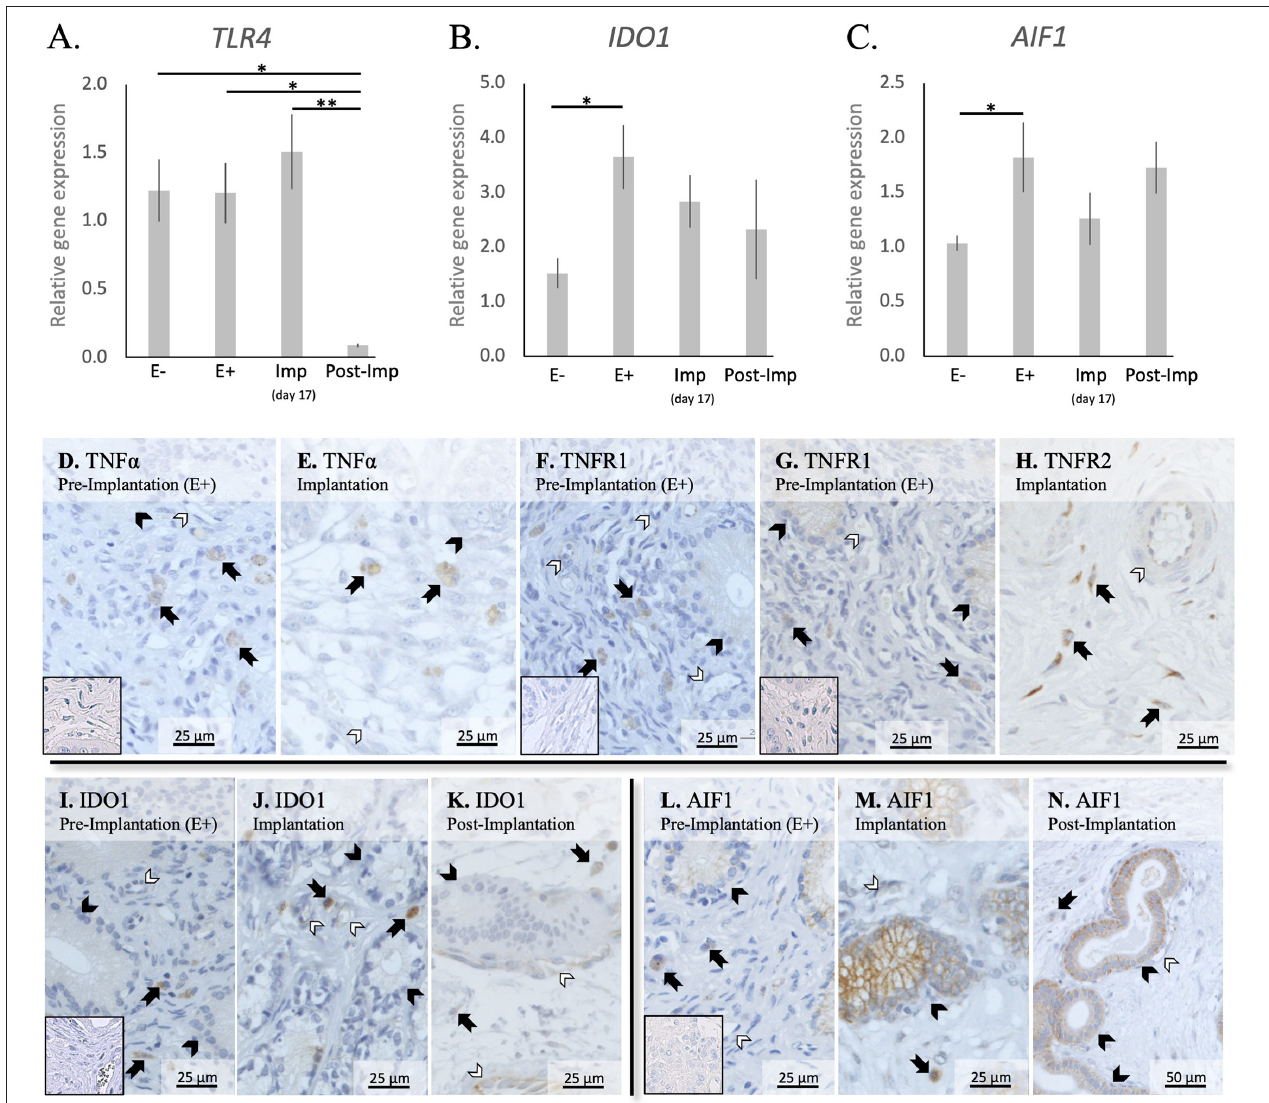
FIGURE 4 | Relative gene expression and localization of TLR4, IDO1 and AIF1 in the canine uterus. (A–C) Relative gene expression as determined by semi-quantitative real time (TaqMan) PCR (mean ± SEM). One-way ANOVA was applied to test the variation among the investigated groups, revealing: P = 0.0033 for TLR4 , P = 0.03 for IDO1 , and P = 0.04 for AIF1 . In the case of P < 0.05, this was followed by Tukey-Kramer multiple comparisons post-test. Bars with asterisks differ at: * P < 0.05, ** P < 0.01. (D–M) Immunohistochemical localization of members of the TNF-system, IDO1, and AIF1 in the canine uterus at selected stages of early pregnancy. Signals of TNF α were present in macrophages during the pre-implantation (D) and implantation (E) periods. Similarly, both TNFR1 (F) and TNFR2 (G,H) were present in macrophages. In addition, weaker signals for both receptors were also observed in epithelial cells of uterine glands during pre-implantation (F,G) and in endothelial cells (F,H) . Positive signals of IDO1 were detected in macrophages between superficial glands during pre-implantation (I) and were also detected in endothelial cells at the time of implantation (J) . At post implantation, weaker signals were observed in macrophages localized in deep endometrium layers, as well as in endothelial cells (K) . AIF1 positive signals were identified in macrophages close to superficial uterine glands in pre-implantation (L) and implantation (M) stages, while at post-implantation they were localized in the deep layer of the endometrium (N) . Some weak signals were also observed in uterine glands at the pre-implantation period (L) , while apparently stronger signals were observed in the same glands at implantation (M) and post-implantation (N) . Weak positive signals were also detected in endothelial cells (M , N) (solid arrow = macrophages; closed arrowhead = uterine gland; open arrowhead = blood vessel). No staining is observed in the isotype controls [inset in (D,F,G,I,L)